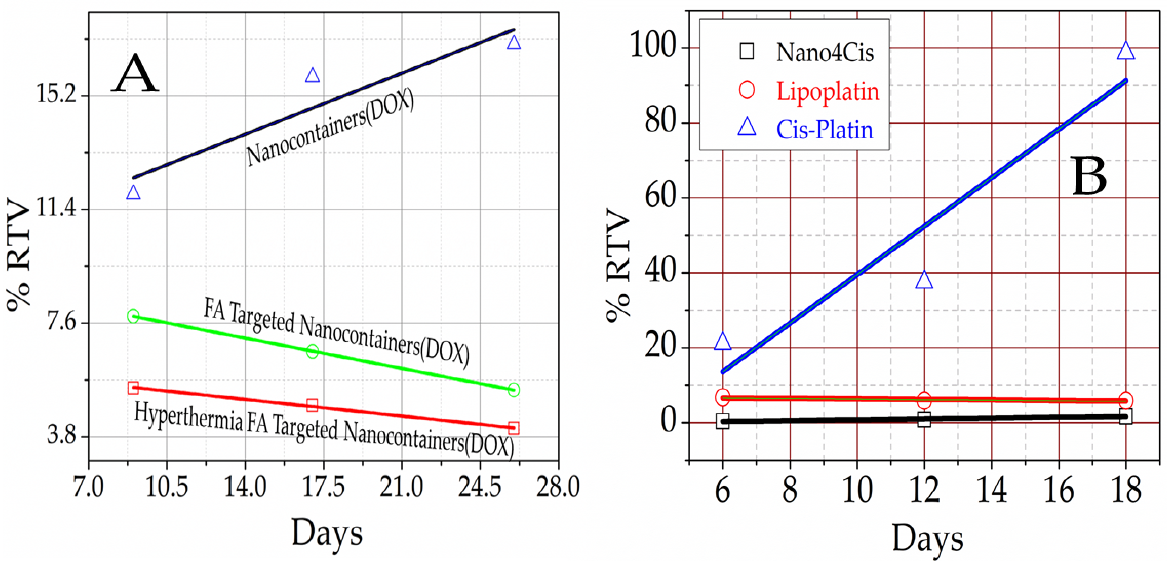
Figure 15. ( A ) The behavior of Nano4Dox. (Black line) increased cancer volume when nanocontainers were delivered with DOX; (green line) decrease in cancer volume when delivering FA-targeted nanocontainers loaded with DOX; (red line) decrease in cancer volume of FA-targeted nanocontainers loaded with DOX with an application of hyperthermia. ( B ) (Blue line) Increase in cancer volume when delivering cisplatin; (red line) decrease in cancer volume when producing cisplatin; (black line) further reduction in cancer volume with disposal of Nano4Cis